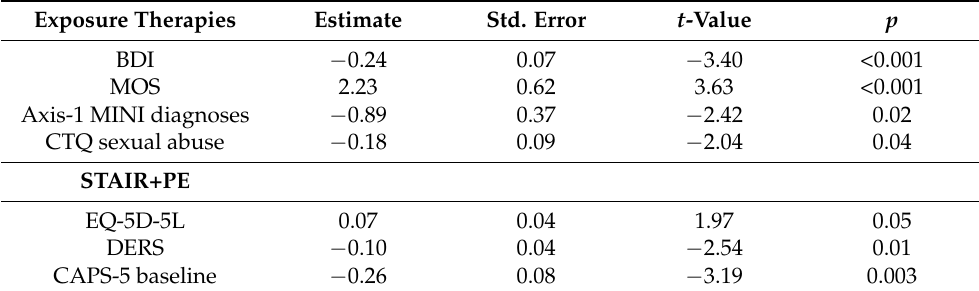
Table 2. Final prediction models of exposure therapies and STAIR+PE with calculated change in CAPS-5 score baseline to posttreatment as the outcome variable.